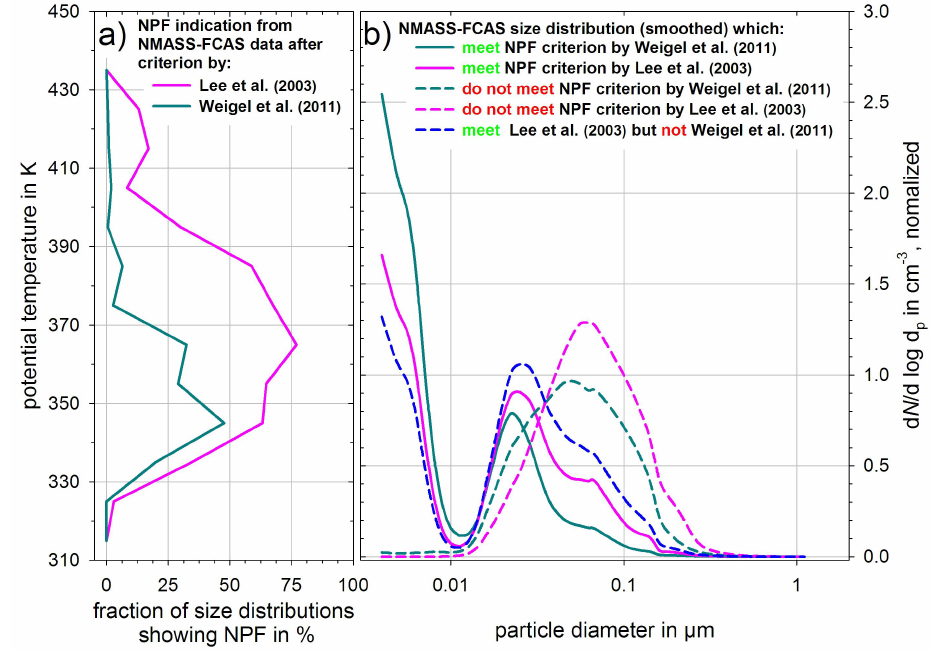
Fig. 2. Two different NPF criteria applied on NMASS-FCAS data measured on board the NASA WB-57F over Central America. (a) Fraction of 5530 aerosol size distributions that either meet the NPF criterion according to Lee et al. (2003) or the more conservative NPF criterion of the present work (labled “Weigel et al., 2011”). (b) Mean normalized and smoothed aerosol size distributions in the altitude range 325–395K that satisfy or not one of these